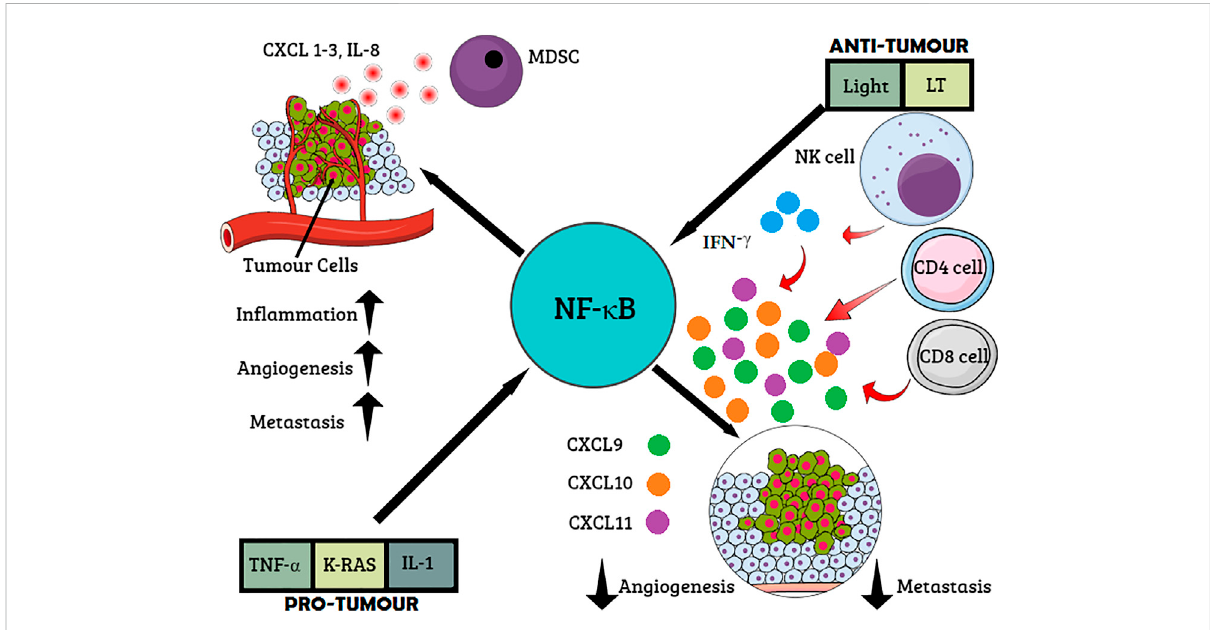
FIGURE 2 Role of NF- κ B cancer immunosurveillance. Proin fl ammatory cytokines and oncogenes activate NF- κ B resulting in the expression of proin fl ammatory mediators such as chemokine CXCL 1-3, interleukin-8 (IL-8), and (C-X-C motif) ligand. The recruitment of myeloid-derived suppressor cells (MDSCs) inhibits the antitumor response. In fl ammation, angiogenesis, and metastasis are stimulated via multiple chemokines. On the other hand, interferon (IFN)- γ produced by T cells or natural killer (NK) cells stimulates the secretion of CXCL9 – 11, which, in turn, in fl icts antiangiogenic and antimetastatic effects.